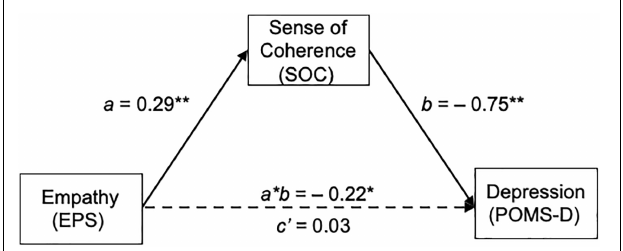
FIGURE 3 | Mediation effect of SOC on the relationship between empathy and self-depression mood (POMS-D). EPS, empathy; SOC, sense of coherence; POMS-D, profile of mood state